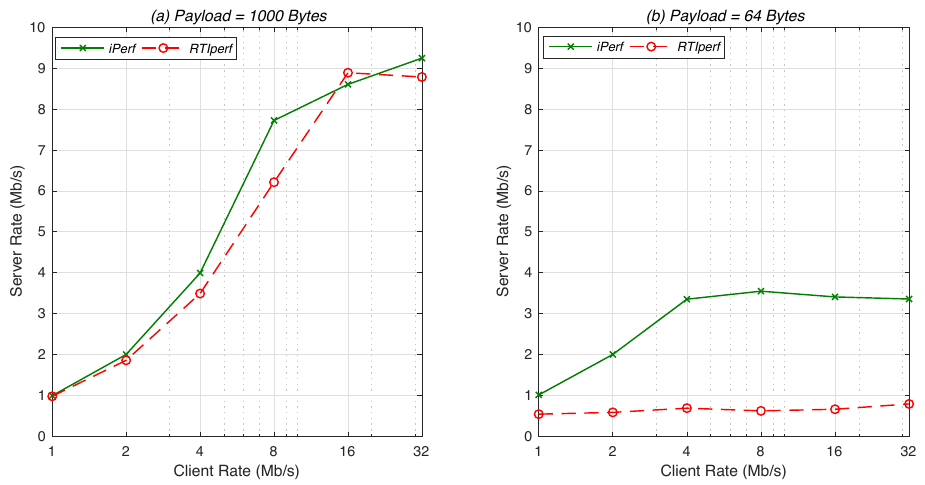
Figure 6. Measurements of the achieved throughput with: large PDU ( left ); and small PDU ( right